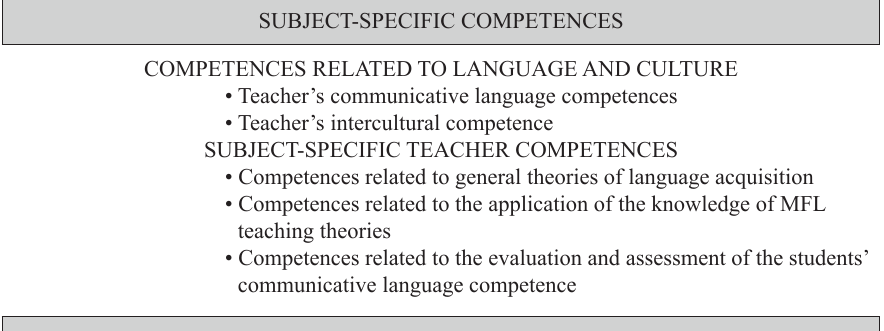
Table 1. Competences of Primary School Foreign language Teacher in the Repu- blic of